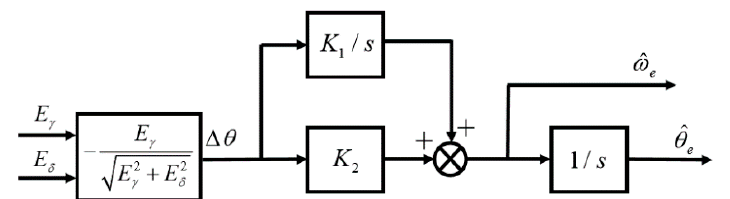
Figure 3. Structure of phased-locked loop for position tracker based on the estimated extended back-EMF.